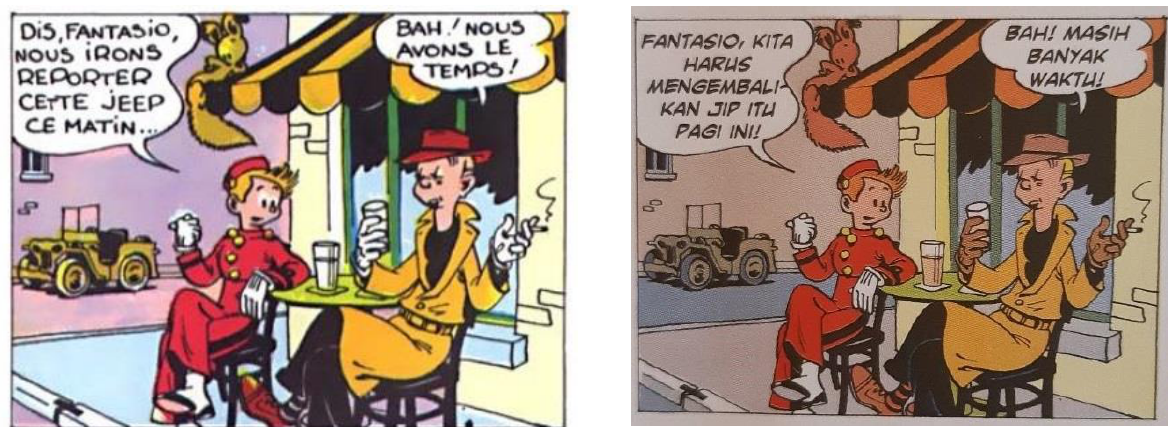
Figure 4 Spirou et Fantasio (l’équivalence